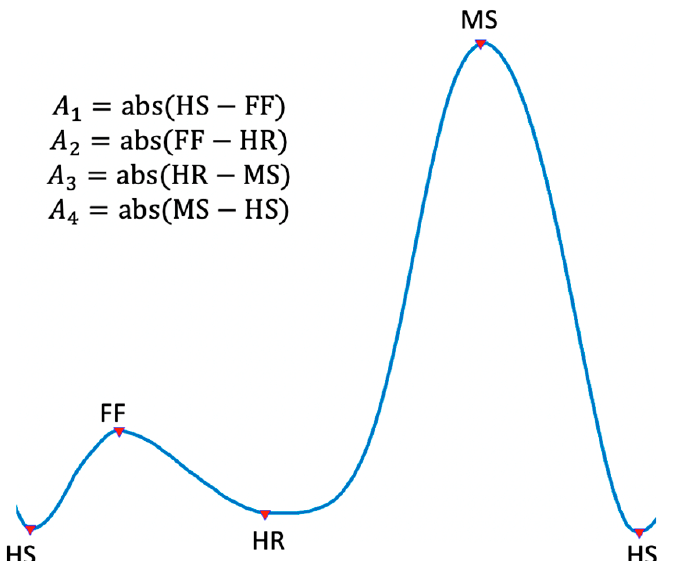
Figure 7. Location of the peaks in the gait cycle and calculation of each difference (A 1 , A 2 , A 3 , A 4 ). There are two peaks during flexion: Foot-flat (FF) and Mid-Swing (MS); and two peaks during extension: Heel-Strike (HS) and Heel-Raise (HR).